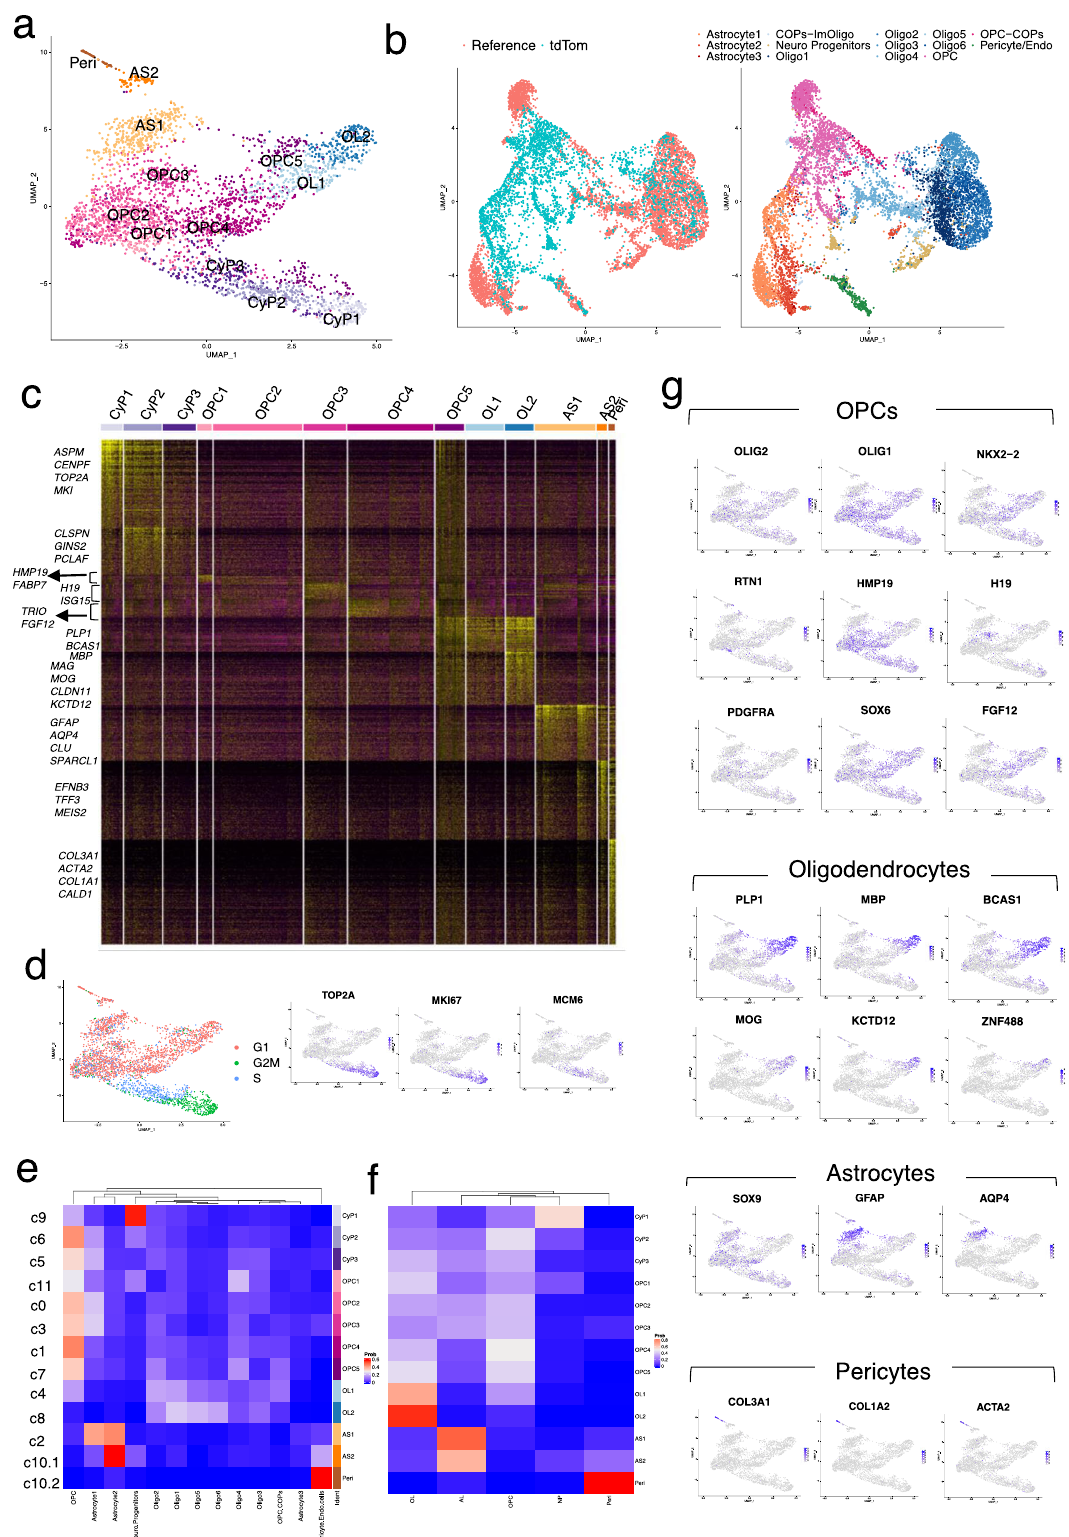
Potential of PDGFR α + precursor cells to differentiate into cells expressing astrocyte markers . Of all the single cells analyzed, 901 (27.5%) expressed GFAP and 733 (22.4%) expressed MBP , mar- kers for astrocyte lineage cells (ALCs) and OLLCs, respectively (Supplementary Fig. 5f). The number of OPCs decrease while the number of OL and AS cells increase over time as they mature